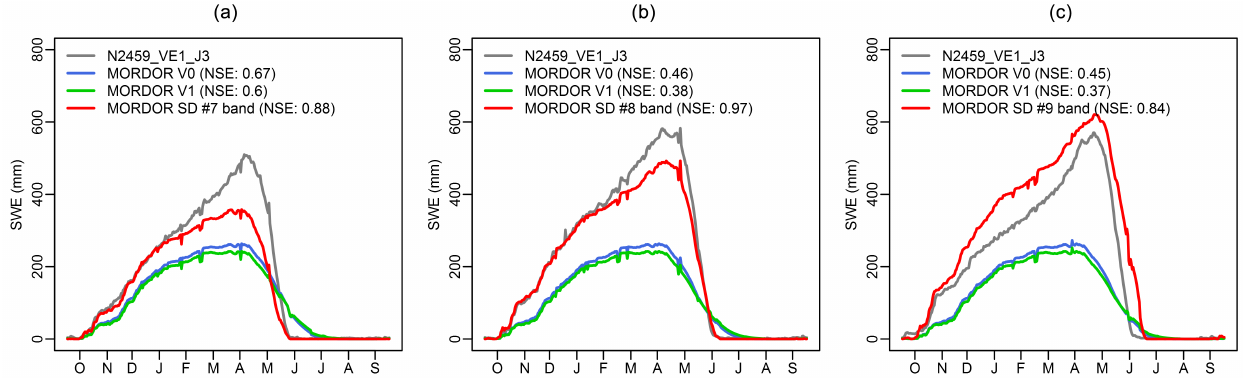
Figure 7. Observed and simulated snow water equivalent (SWE) regimes on the Durance at La Clapière catchment, for three measurement stations: (a) Izoard (2280ma.s.l.), (b) Chardonnet (2455ma.s.l.) and (c) Marrous (2730ma.s.l.). NSE values are calculated on SWE regimes.